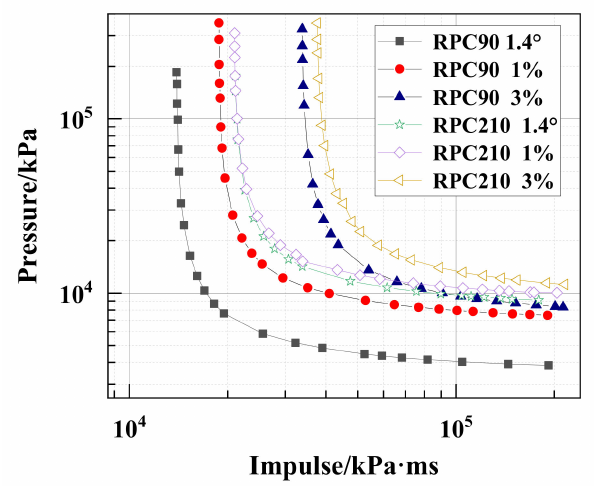
Figure 17. Analysis of P-I curves with two RPC strengths, 90 MPa and 210